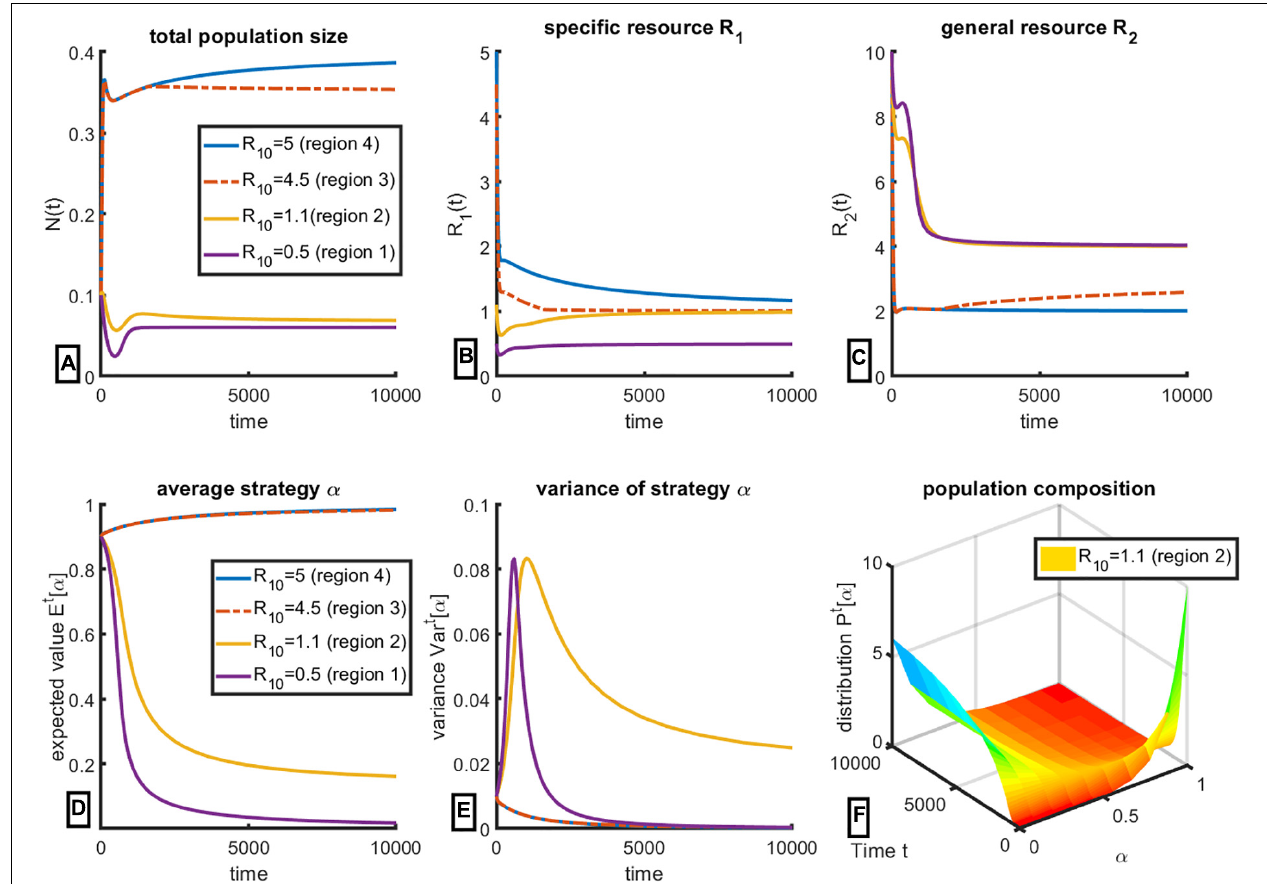
FIGURE 2 | Evolution of the population of consumers over time with respect to resource consumption strategy subject to change in resource availability. Initial values of R 01 were chosen to provide representative plots of the 4 key regions of Figure 1 . (A) Change in total population size N(t); (B) Equilibrium level of specific resource R 1 (here interpreted as estrogen) and (C) equilibrium level of general resource R 2 , here interpreted as glucose, calculated from System (Oksanen and Oksanen, 2000); (D) change in mean strategy α ∈ [ 0 , 1 ] ; (E) change in variance of α over time; (F) a representative plot of change in population composition changes over time, for R 01 = 1 . 1, corresponding to region 2 of Figure 1 . All other parameter values are held constant at values given in Table 1